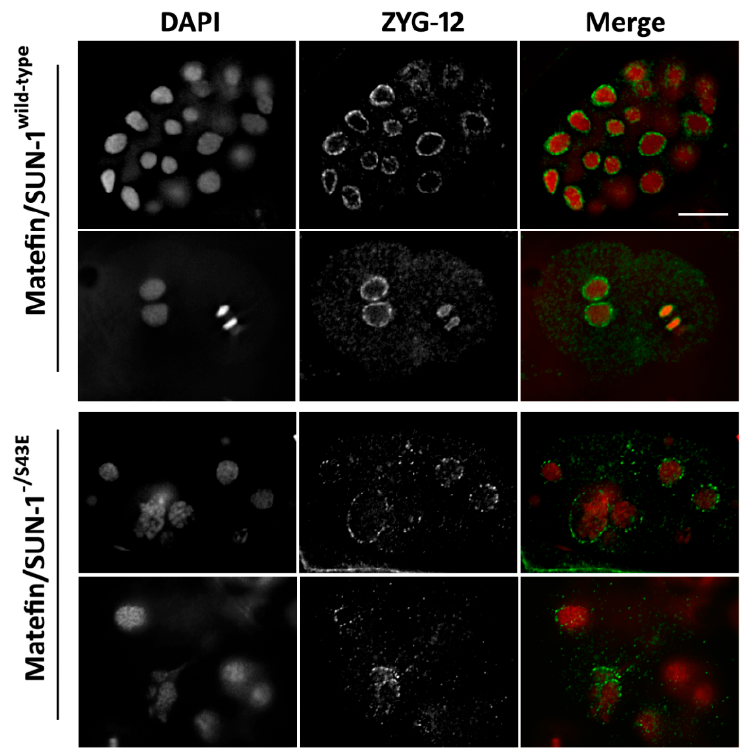
Figure 3. Matefin/SUN-1 pS43 mediates proper NE localization of ZYG- 12. ZYG-12 loses its NE localization in early C. elegans embryos expressing matefin/SUN-1 S43E. Top panels—wild-type matefin/SUN-1 embryos stained with DAPI ( red ) and anti ZYG-12 antibodies ( green ); Bottom panels—matefin/SUN-1 S43E embryos stained with DAPI ( red ) and anti ZYG-12 antibodies ( green ). Scale bar 10 μ m.